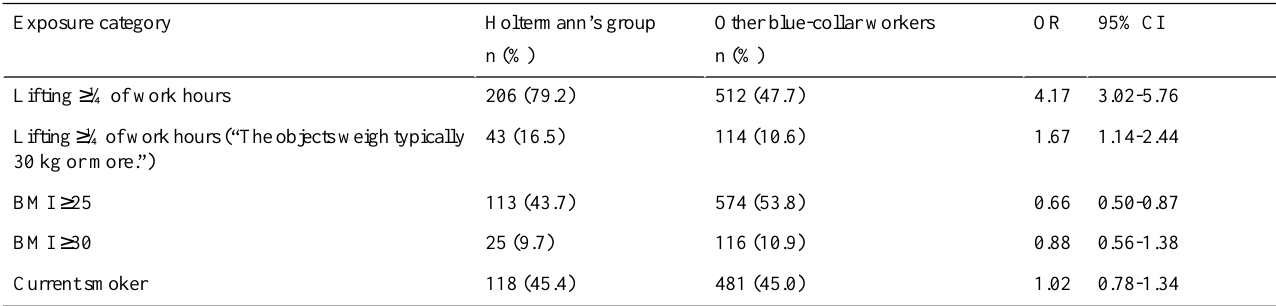
Table 2. Percentage of male workers exposed to occupational lifting, smoking, and high body mass index (BMI) according to DWECS 2000, by occupational category.